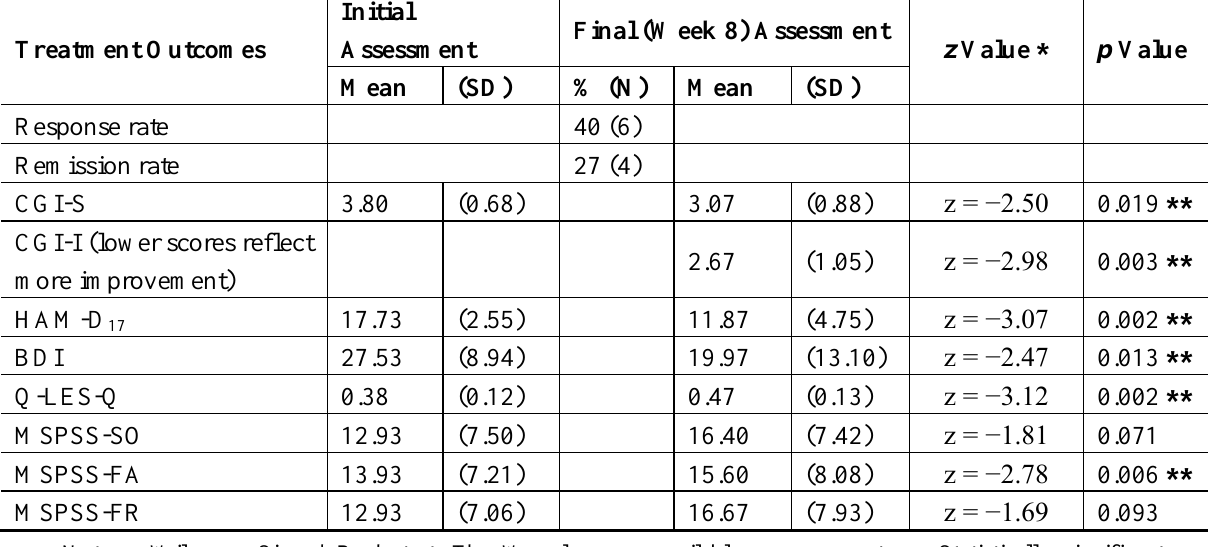
Table 3. Depression treatment outcomes using completer analysis (N =